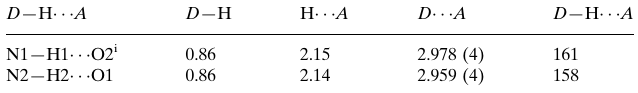
Hydrogen-bond geometry (A˚ , (cid:1)